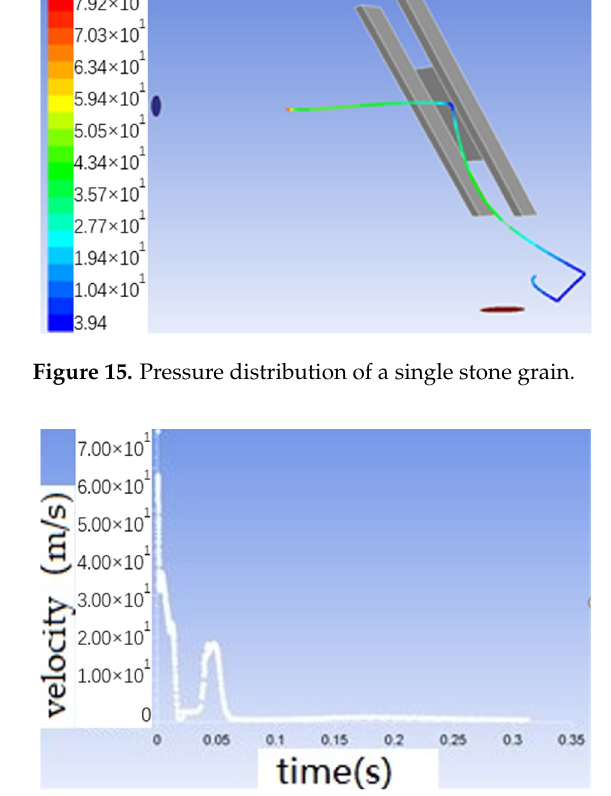
Table 6. Velocity–impact force relationship.